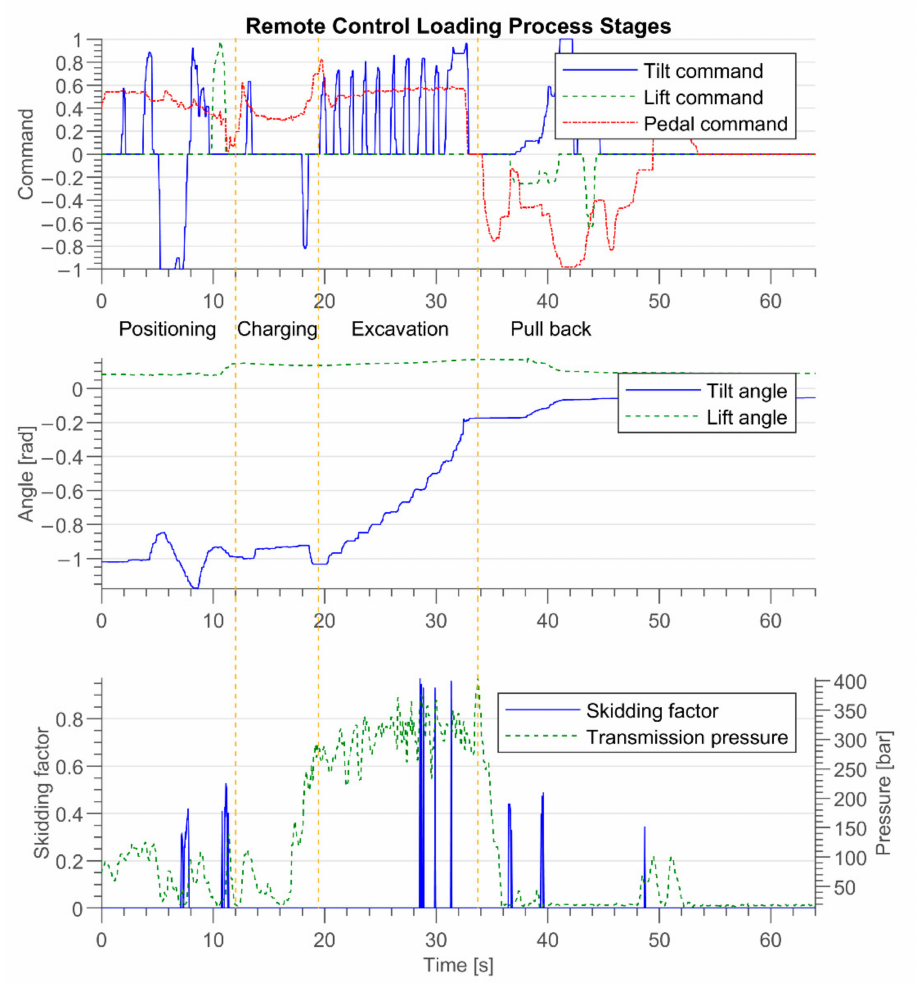
Figure 5. Relevant variables during the loading maneuver: Lift/Tilt command: manual bucket lifting/tilting command. Pedal command: manual machine acceleration command. Transmission Pressure: hydrostatic transmission pressure of the machine. Tilt Angle: tilt angle of the bucket. Lift Angle: lift angle of the boom. Skidding factor: estimated skidding factor. See the definitions of these variables in Sections 3.3 and